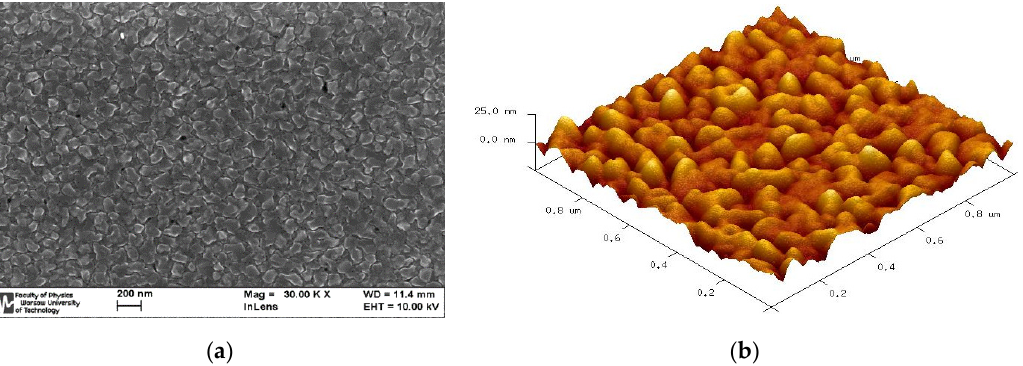
Figure 1. Surface topography of 30 nm Al films sputtered using pulsed-DC magnetron sputtering process: ( a ) HR-SEM, and ( b ) AFM micrographs.